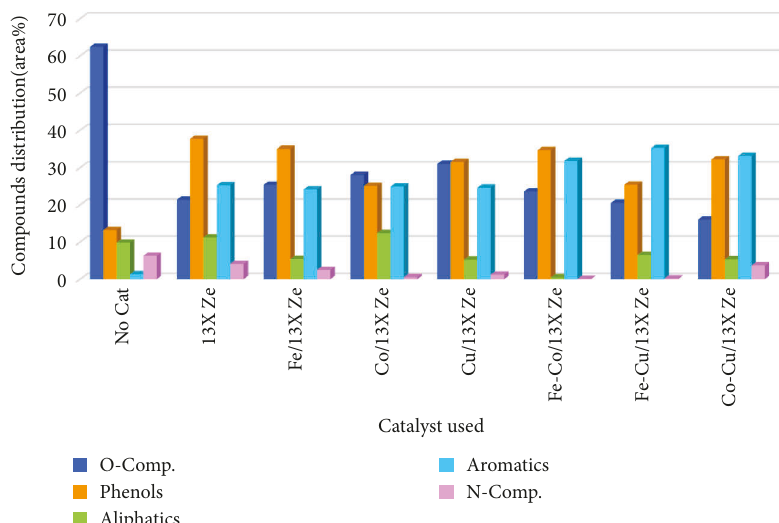
Figure 9: Effect of the metal-modified 13X zeolite catalysts on the distribution of compounds in the bio-oil composition obtained by RRB